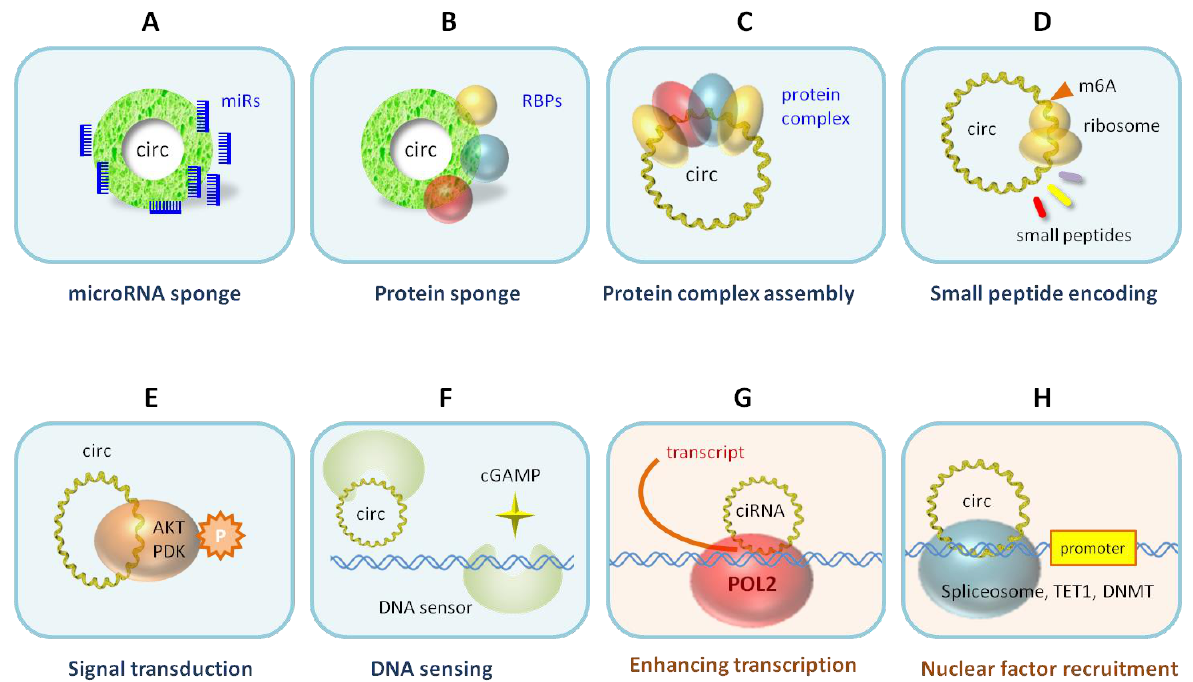
Figure 3. Molecular functions of circRNAs. CircRNAs are localized in the cytoplasm ( A – F ) or in the nucleus ( G , H ) to exert their molecular functions.